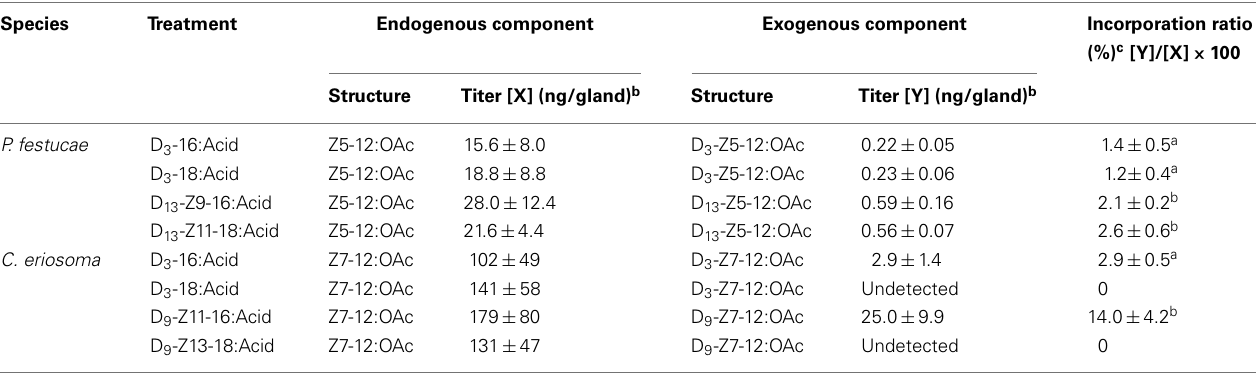
Table 2 |Titers of endogenous and exogenous pheromone components in the sex pheromone glands of Plusia festucae and Chrysodeixis eriosoma females, which were treated with deuterated fatty acids a